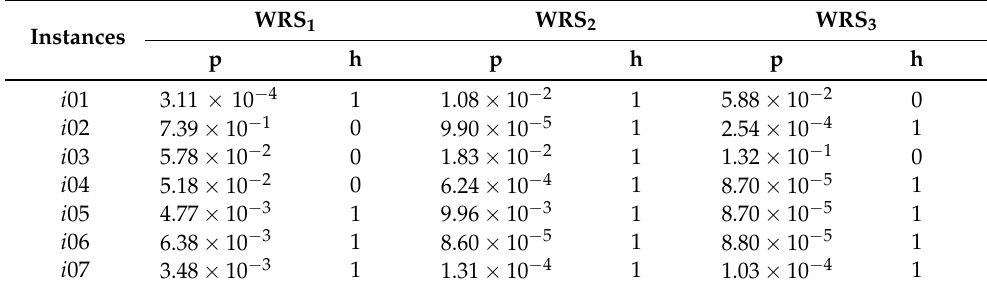
Table 4. The WRS test of different combinatorial